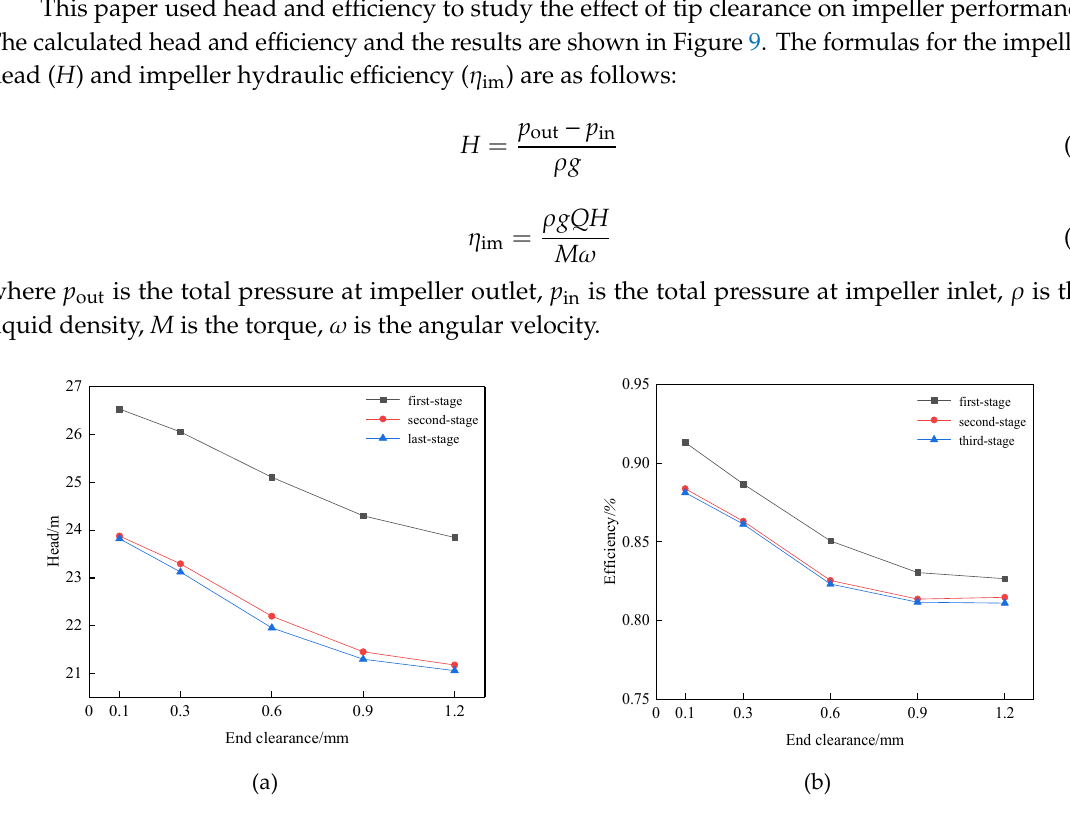
Figure 10. Leakage of different end clearance. Figure 11 is the pressure diagram of the second-stage impeller and cavity under different end clearances at design flow rate. It can be seen that at the 0.3-mm end clearance, the flow inside the impeller was regularly stable, only a small low-pressure area existed in the inlet of impeller. When the end clearance increased to 0.6 mm, 0.9 mm, and 1.2 mm, the low-pressure area appeared inside the impeller. With the increase of the end clearance, this low-pressure area further extended from the impeller inlet to the middle of the impeller passage. Beyond that, the high-pressure fluid returned to the impeller inlet through the end clearance and formed a high-pressure zone, which developed along the shroud edge of the impeller. As the end clearance increased, the leakage flow rose. At 0.6- mm end clearance, separation vortex appeared at the impeller pressure side and further developed into serious flow separation as the increase of end clearance. At 1.2-mm end clearance, the impact of leakage flow on the main flow was obvious at the inlet of impeller passage. Figure 12 is the pressure diagram of the outlet of the second-stage impeller at 1.0 Q d . It is clear that the pressure from hub to shroud was distributed from low to high. This should be attributed to the fact that ESP usually uses inclined impellers to reduce liquid clogging. The hub diameter was shorter than shroud diameter, so the length of the impeller blade was different. Besides, with the increase of the end clearance, a relatively low-pressure region appeared at the hub side. It can be seen from Figure 12 that at the end clearance of 0.6 mm, 0.9 mm, and 1.2 mm, this low-pressure region at the outlet of the impeller gradually increased. At 1.2-mm end clearance, the low-pressure area